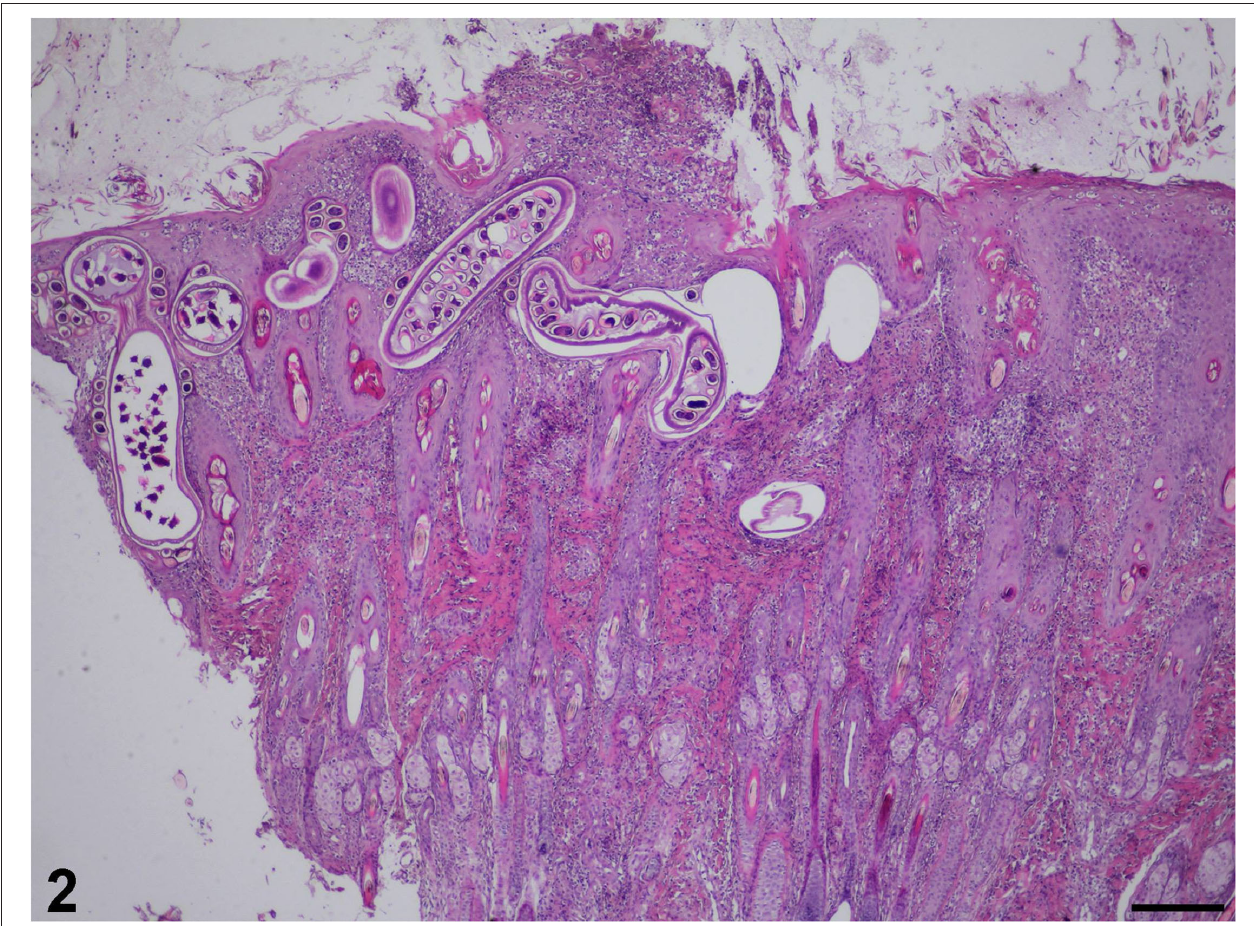
FIGURE 2 | Histopathological section stained with haematoxylin and eosin revealing necrosis in the epidermis and nematode-like lesions in the dermis (200 µ m scale